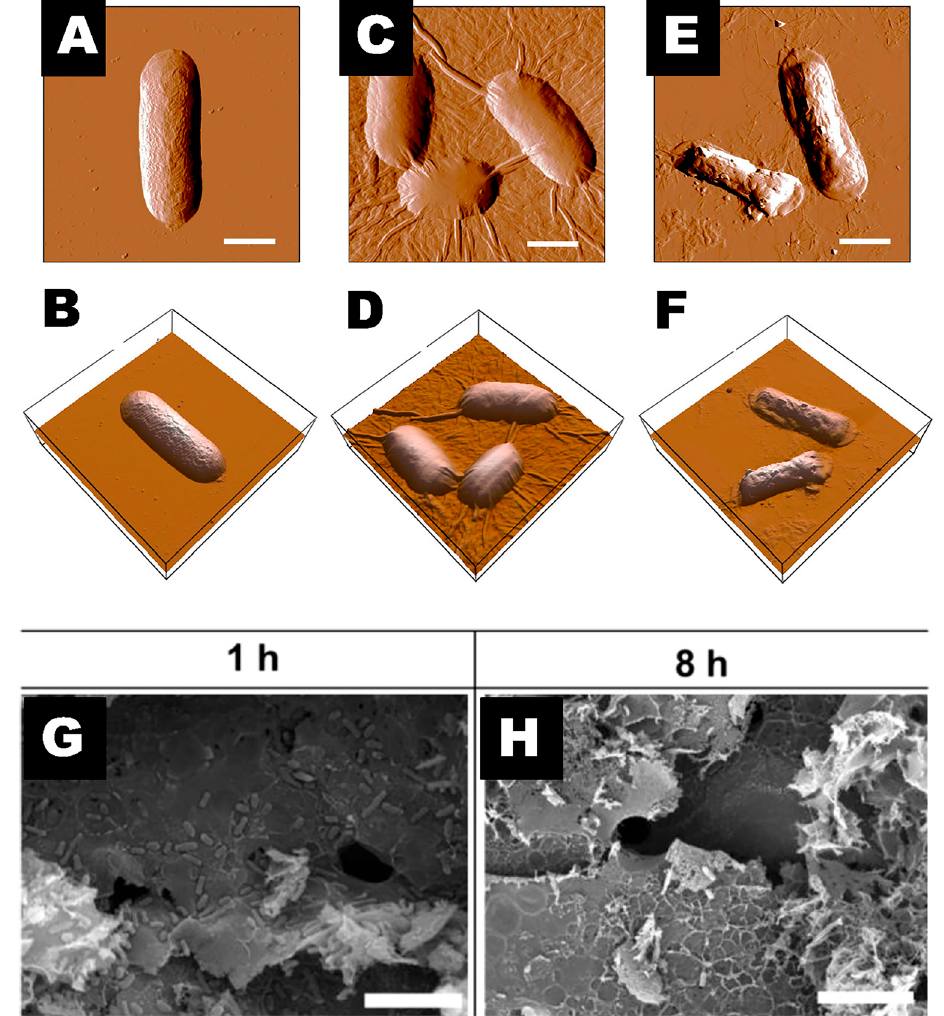
Figure 5. Atomic force microscopy and 3D images of E. coli cells after incubation with graphene oxide (GO). Incubate E. coli with deionized water ( A , B ), 40 µ g/mL GO-0 ( C , D ) and 40 µ g/mL GO-240 ( E , F ) for 2 h. Scale bar is 1 µ m. Reproduced with permission [94]. Copyright 2012, American Chemical Society. ( G , H ) Scanning electron microscopy images of E. coli incubated with laser-induced graphene (LIG) 1 and 8 h. Scale bar is 10 µ m. Reproduced with permission [95]. Copyright 2020, American Chemical